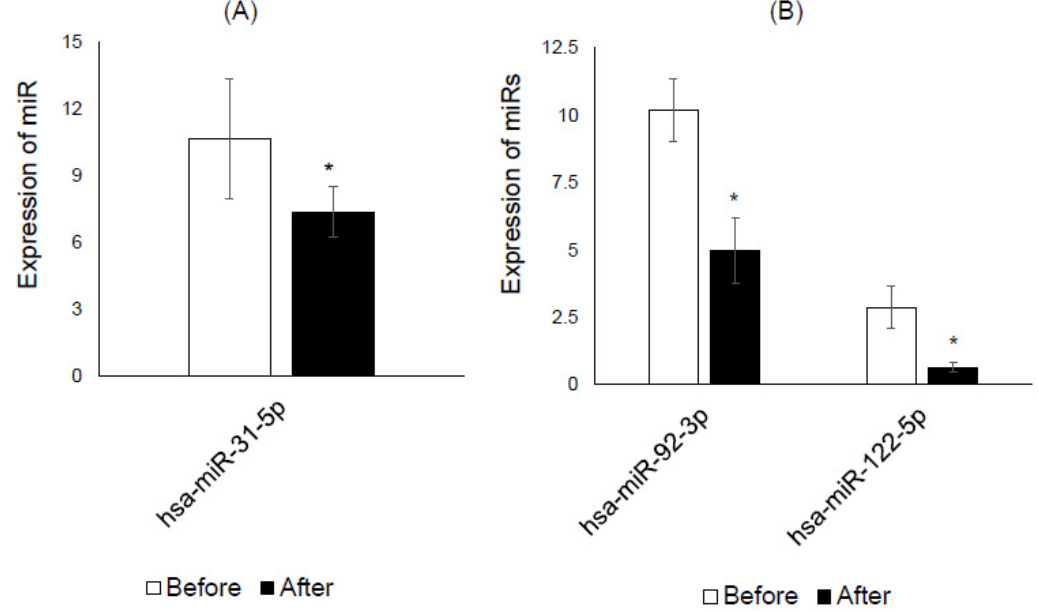
Figure 2. Validation of saliva miRs by RT-qPCR. ( A ) Hsa-miR-31-5p was down-regulated in the saliva of the control diet group. ( B ) Hsa-miR-92-3p and hsa-miR-122-5p were down-regulated in the saliva of the K-diet group. White and black columns represent miR expression before and after the intervention, respectively. * p < 0.05 by paired t -test.